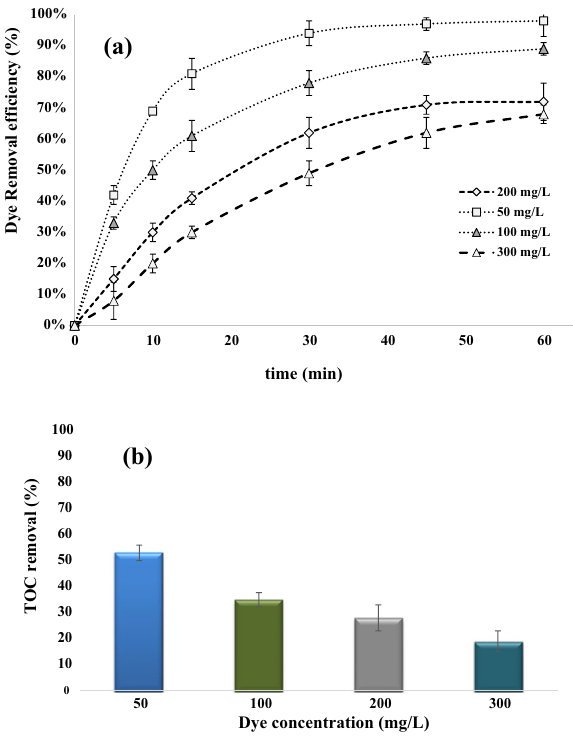
Fig. 2 The effect of the initial pH (5, 6, 7, 8 and 9) of the solution on dye discoloration (2a) as well as TOC removal and the changes in pH during the reaction time (2b) in the ozonation process ([RR-198]: 50 mg/L and ozone dose: 40 mg/L min)